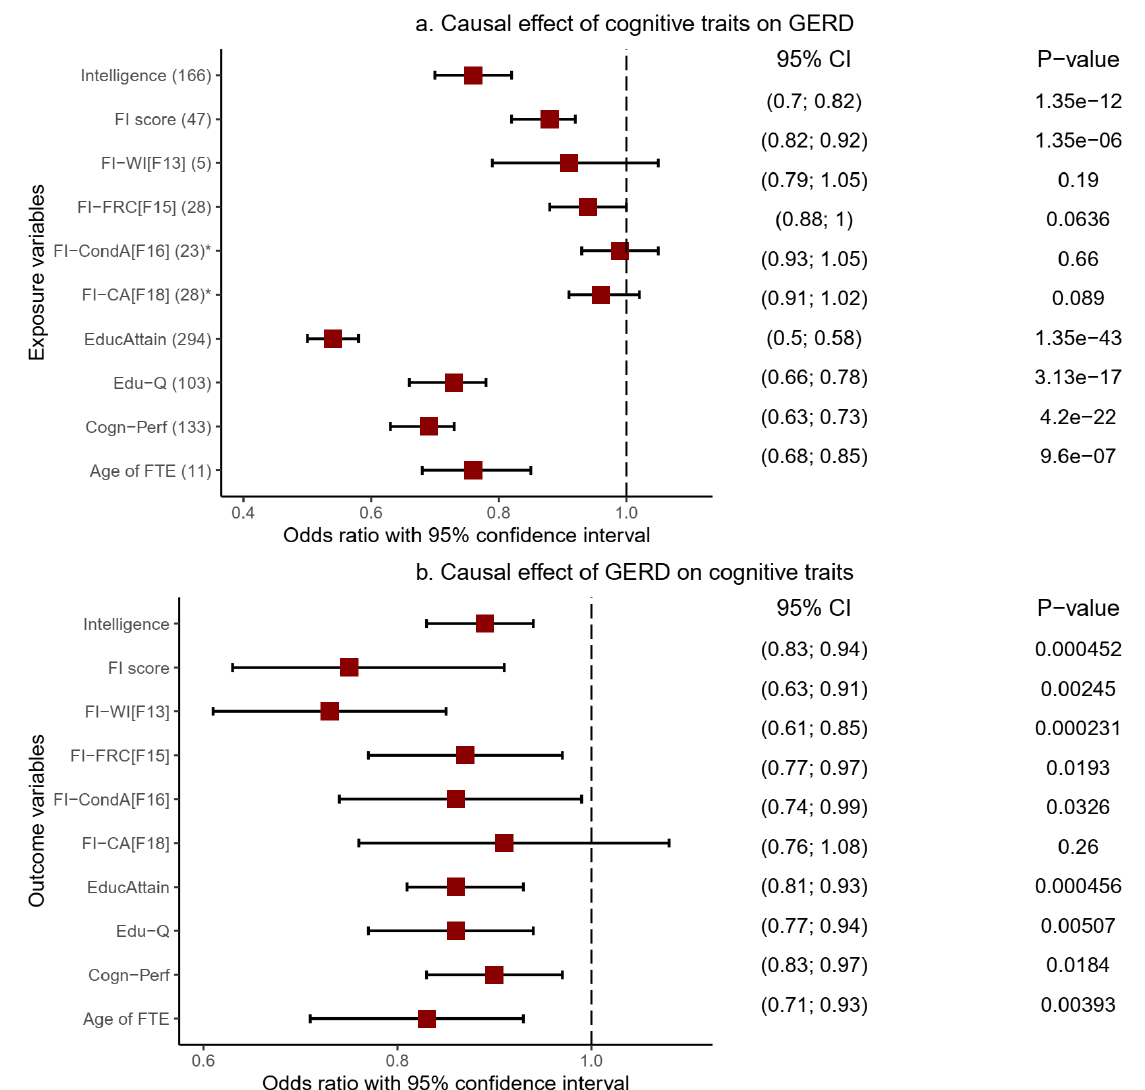
Figure 5. Causal relationship between cognitive traits and GERD based on the IVW MR model. GERD: gastroesophageal reflux disease, Age of FTE: age completed full-time education, FI-CA[F18]: fluid intelligence-chained arithmetic, FI-CondA[F16]: fluid intelligence-conditional arithmetic, FI- FRC[F15]: fluid intelligence-family relationship calculation, FI-WI[F13]: fluid intelligence-word interpolation, Cogn-Perf: cognitive performance, EducAttain: educational attainment, * instrumental variables selected at P snp < 1 × 10 −5 , ivw: inverse variance weighted, MR: Mendelian randomisation.